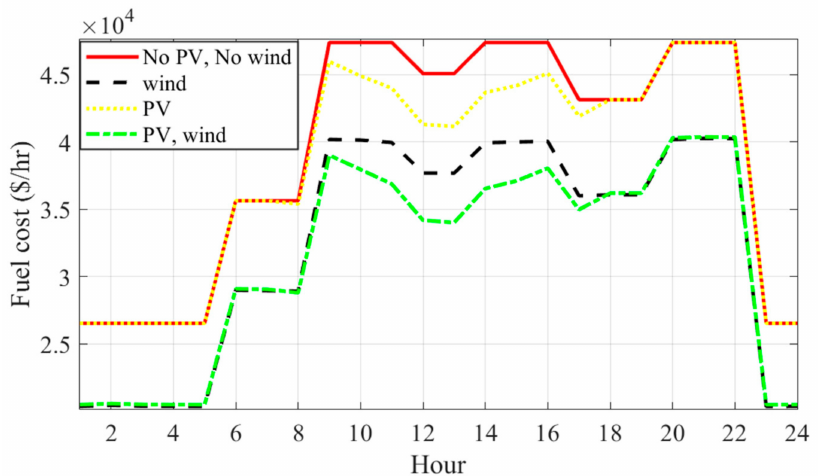
Figure 7. Hourly fuel cost of the four scenarios of the 57-bus system.